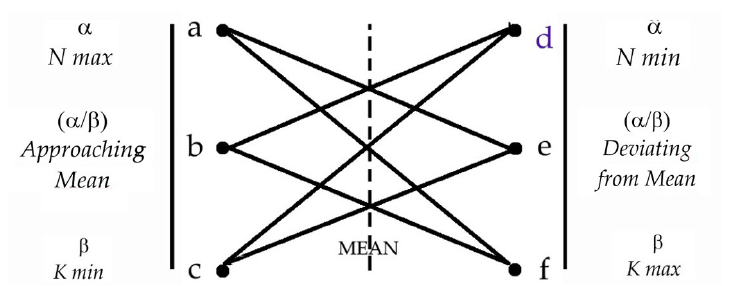
Figure 1. Mapping search experience in GRAPHYP: a–f, as the six typical modelizable cliques combining triplets of nodes, included in a cognitive community [46].